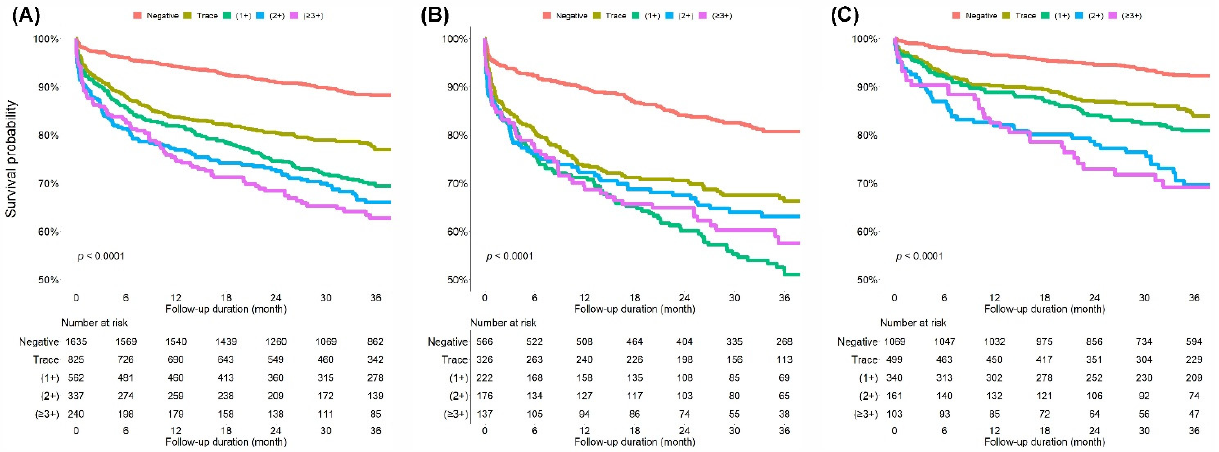
Figure 2. Kaplan–Meier curves display the survival probability of all-cause mortality according to the degree of dipstick proteinuria. ( A ) All patients. ( B ) Patients with acute HMOD. ( C ) Patients without acute HMOD. HMOD, hypertension-mediated organ damage. Table 3. Hazard ratios for mortality according to dipstick proteinuria among patients with hyperten- sive